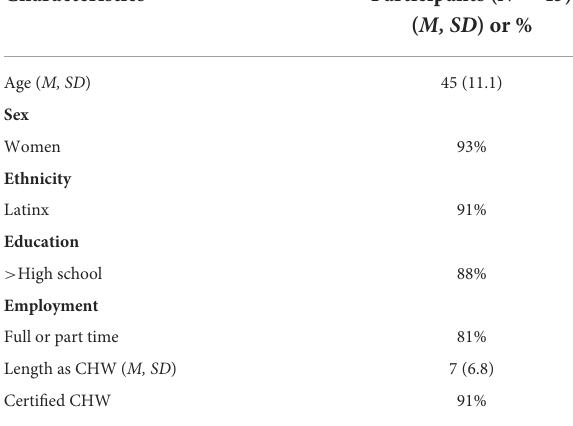
TABLE 1 Characteristics of